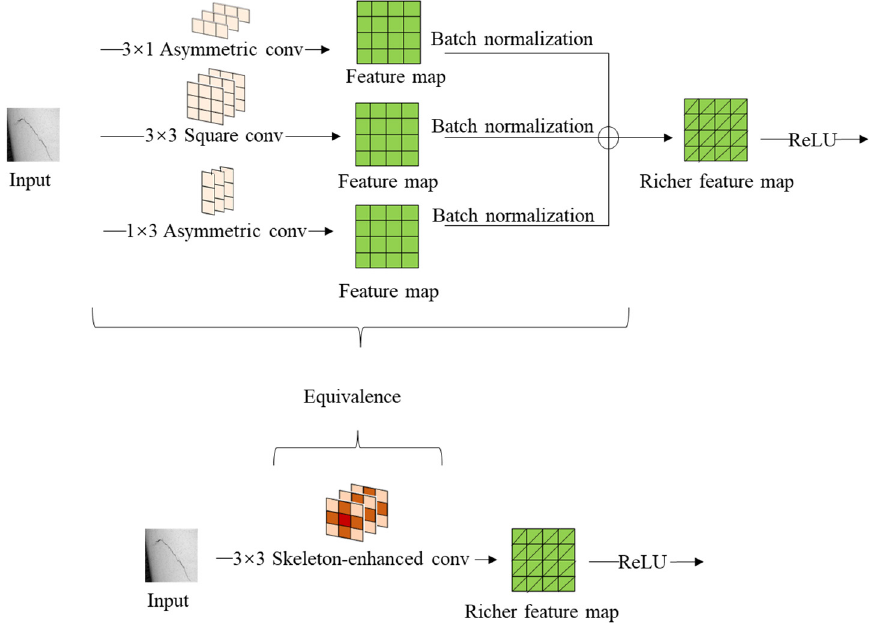
Figure 5. After the three convolutional branches extract the features, they are batch-normalized and added together. This operation process is equivalent in effect to a skeleton-enhanced convolution extracting features on the input. Both convolution processes extract a richer feature map.